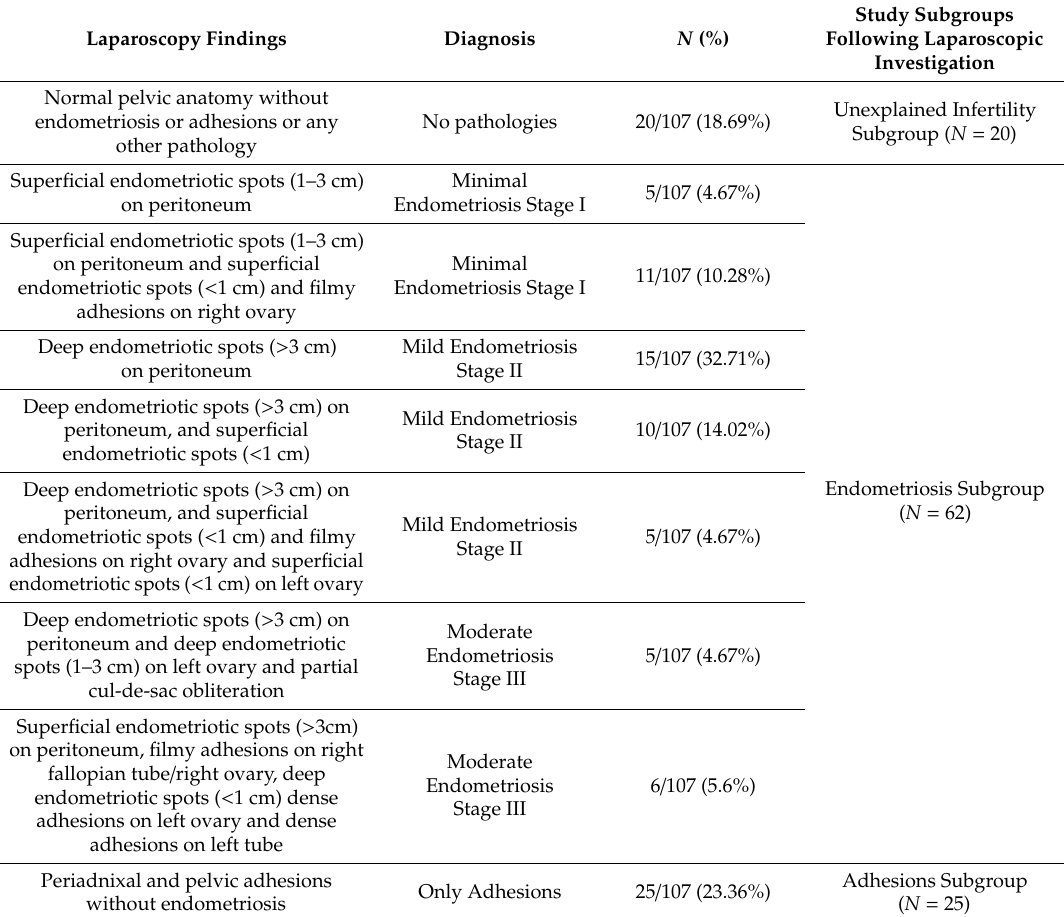
Table 1. Description of di ff erent pathologies diagnosed and treated during laparoscopic